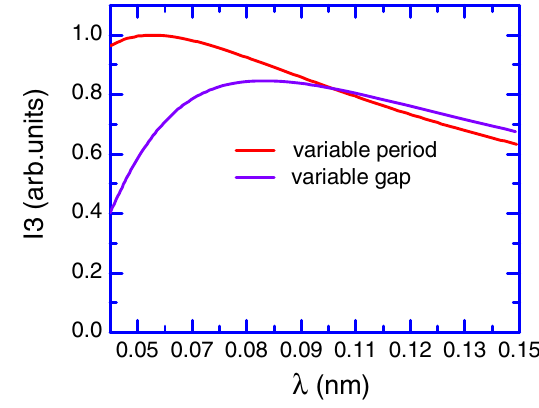
FIG. 8. The spectral intensities of the third harmonics.